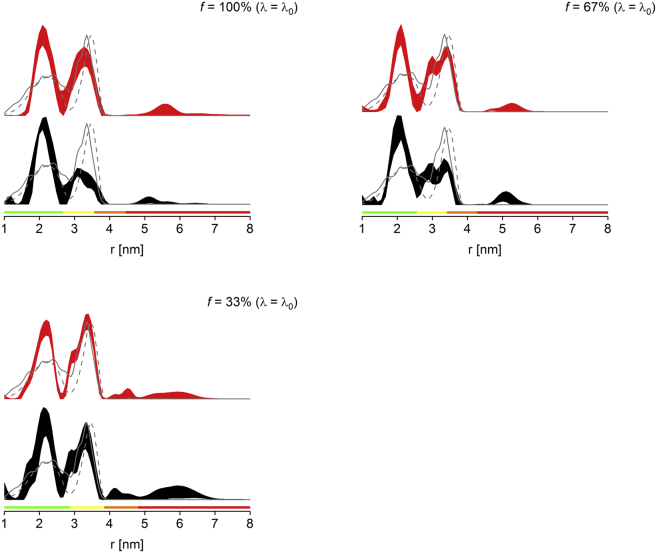
MscL V120R1 PELDOR distance distributions obtained for fully labeled protein at X-band (top left), and sparsely labeled protein (top right, f = 67%; bottom left, f = 33%). See Fig. 1 for details on the 2σ confidence intervals, predicted distance distributions, and color bars. See Supporting Material for raw PELDOR data and processing. To see this figure in color, go online.